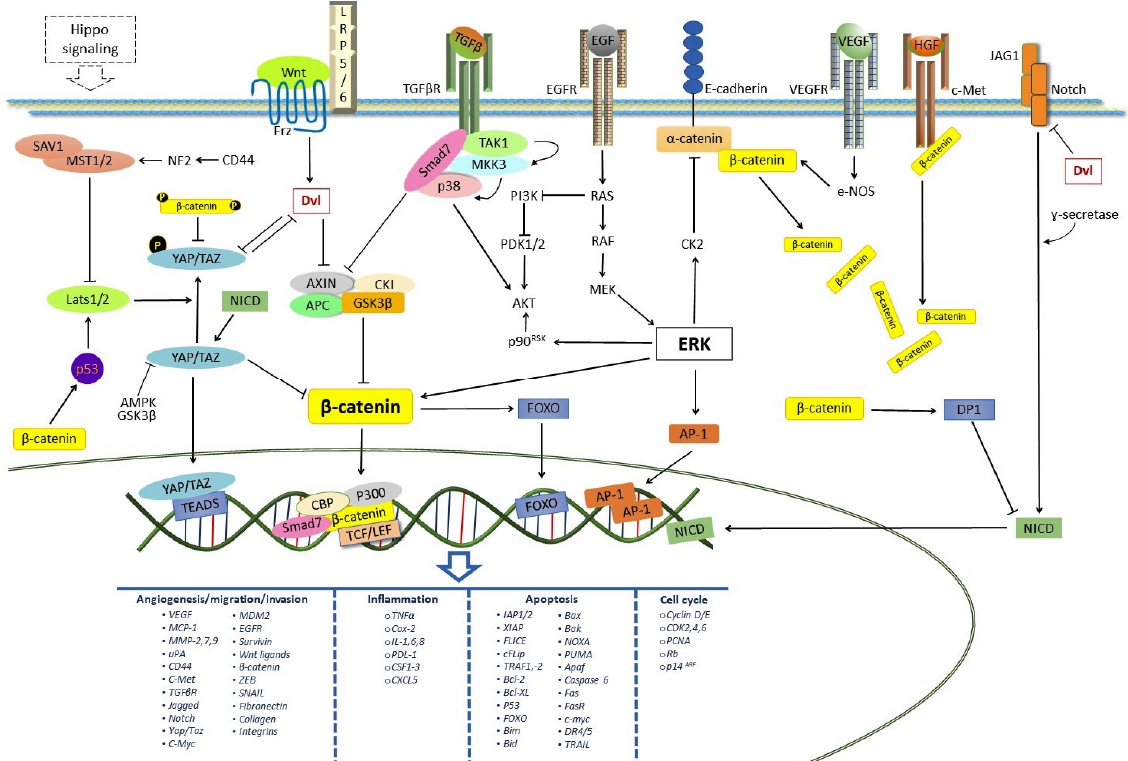
Figure 2. The crosstalk of the Wnt/β-catenin pathway with the Hippo, TGFβ, EGFR, VEGF, c-Met, and Notch signaling pathways modulates cancer progression and apoptosis, depending on the cellular context. An activation of the canonical Wnt pathway induces the stability of cytoplasmic β-catenin when the Wnt ligand binds FZ/Lrp5/6. This leads to a phosphorylation of Dvl, which inactivates the Destruction Complex, allowing an increase in the levels of free cytoplasmic β-catenin, which is then translocated to the nucleus, bound to TCF/LEF and transcription activators, to induce genic expression. On the other hand, the Hippo signaling increases β-catenin cytoplasmic levels by inactivating YAP/TAZ via SAV/MST1/2/LATS 1/2. When phosphorylated, YAP/TAZ activates the destruction complex via Dvl inhibition and sequestration of β-catenin. However, β-catenin also inhibits YAP/TAZ via Dvl and proteasomal activity, blocking the genic expression induced by YAP/TAZ. The Hippo signaling is activated via CD44/NF2 and p53. The TGFβ signaling pathway can also induce the cytoplasmic stability of β-catenin through smad 7. In turn, smad 7 interacts with TAK1 and MKK3, leading to the activation of p38 and the subsequent activation of AKT, inactivation of GSK 3β, and stabilization of β-catenin. The EGF pathway also can induce an increase in free cytoplasmic β-catenin by promoting the phosphorylation (inactivation) of α-catenin bound to E-cadherin through ERK activation. The VEGFR pathway also can increase the cytoplasmic levels of β-catenin through eNOS activation, which induces the S-nitrosylation of β-catenin, promoting its dissociation from α-catenin and its nuclear translocation. In addition, after the HGF ligand binds its receptor, c-MET promotes the phosphorylation of c-Met-associated β-catenin and a subsequent release of free cytoplasmic β-catenin. However, the activation of the Notch pathway by its Jagger ligand can decrease the cytoplasmic levels of β-catenin through the induction of DKK and Yap/Taz transcripts, which inhibit the Wnt/β-catenin pathway. Conversely, the Wnt/β-catenin pathway inhibits the Notch pathway through Dvl and DP1. Additionally, β-catenin induces the activation of the pro-apoptotic transcriptional factor FOXO. Depending on the cellular context, this could lead either to a carcinogenic process or a cell death process on cancer cells. Continue arrows ( ↓ ) indicate activation, arrows with ( ⊥ ) indicate inhibition.